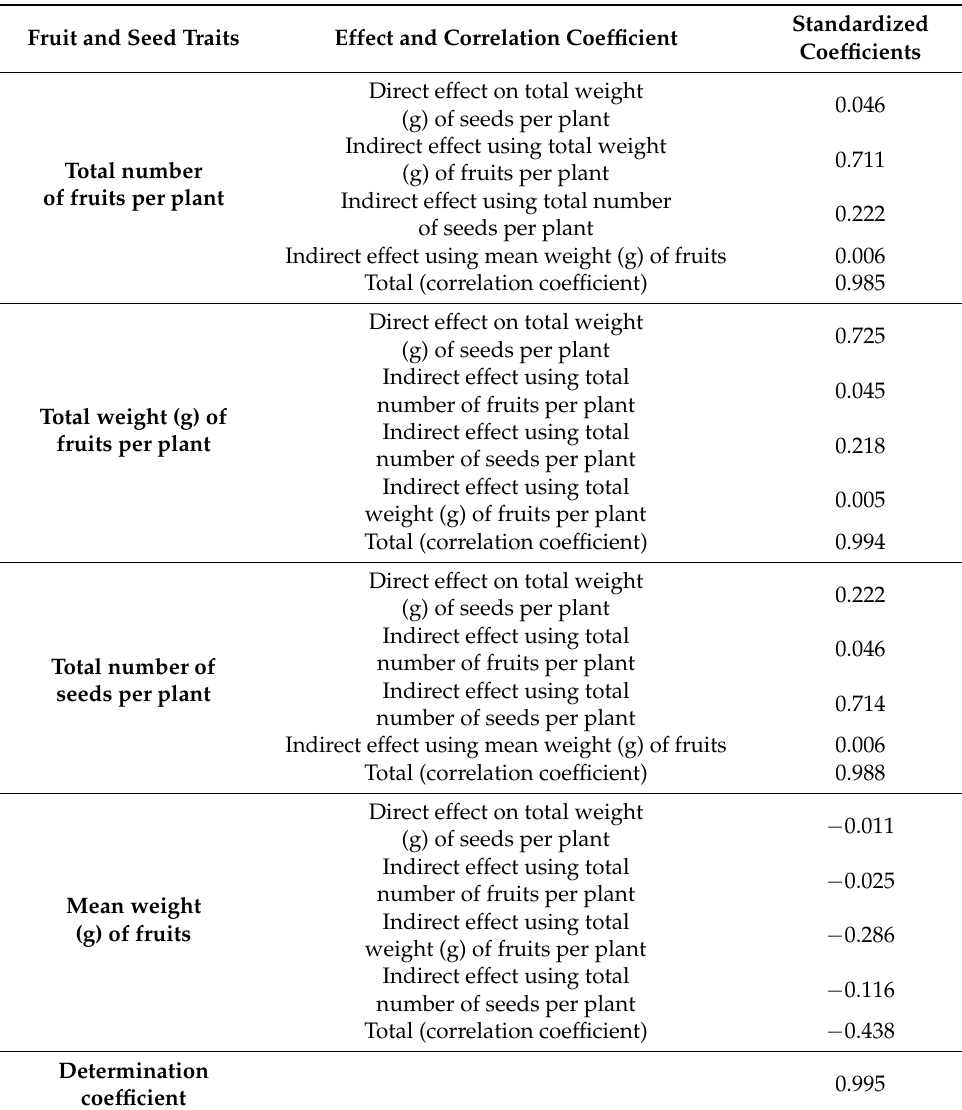
Table 4. Estimated effects of fruit and seed traits on the total weight and seed weight of plants from 12 sacha-inchi progenies. Fruit and Seed